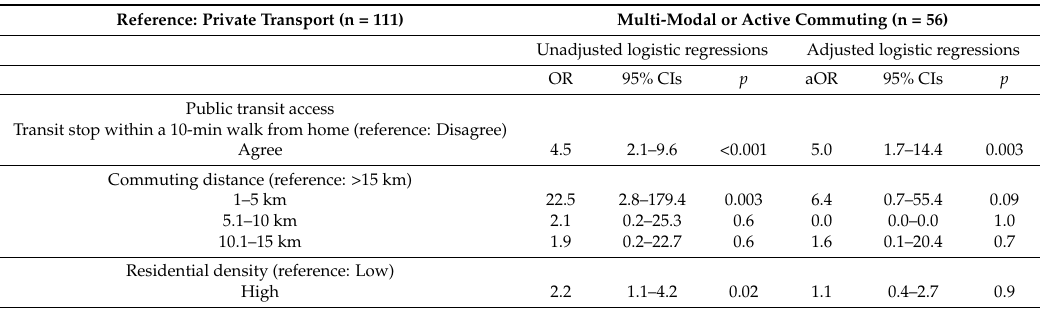
Table 3. Crude and adjusted odds ratios examining associations between multi-modal or active commuting vs. private transport and home neighborhood supports in Chennai, India (Model